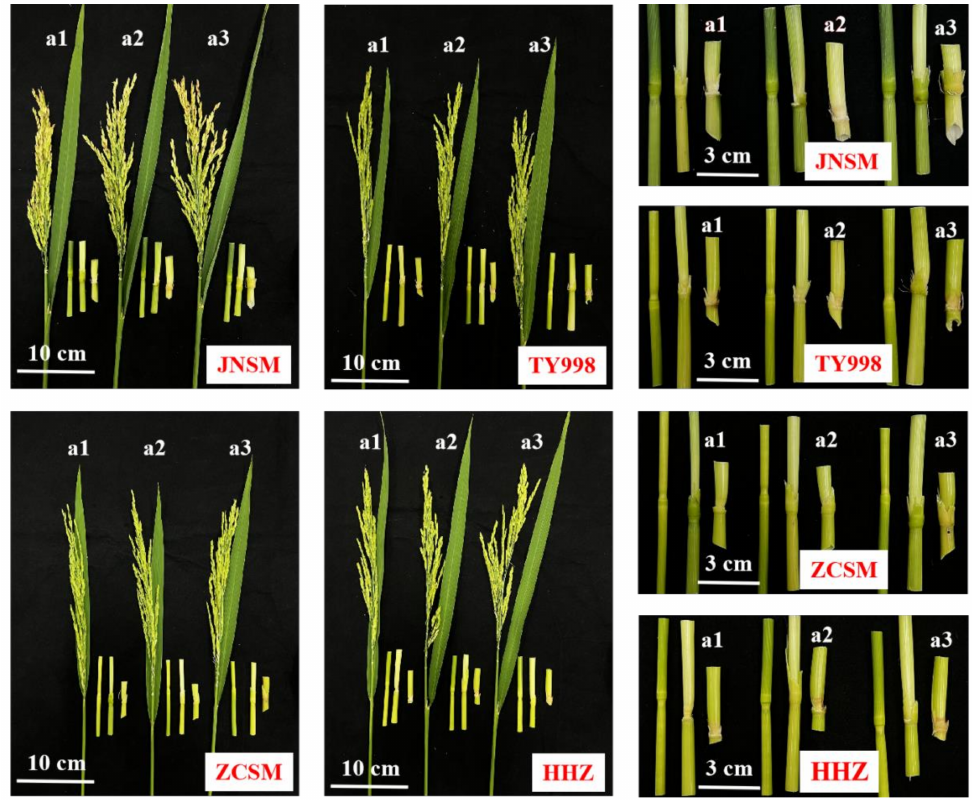
Figure 3. Photos of panicle and internode of four rice cultivars under high N level. a1, a2, and a3 indicated rice seedlings with the control, CSiF, or SOSSiF treatment, respectively. For the internodes of each rice variety, the first, second, and third internodes of rice are from right to